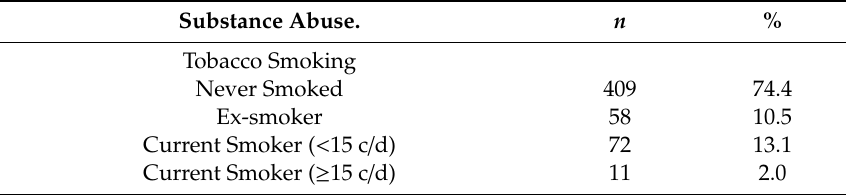
Table 2. Prevalence of substance use in students ( n =